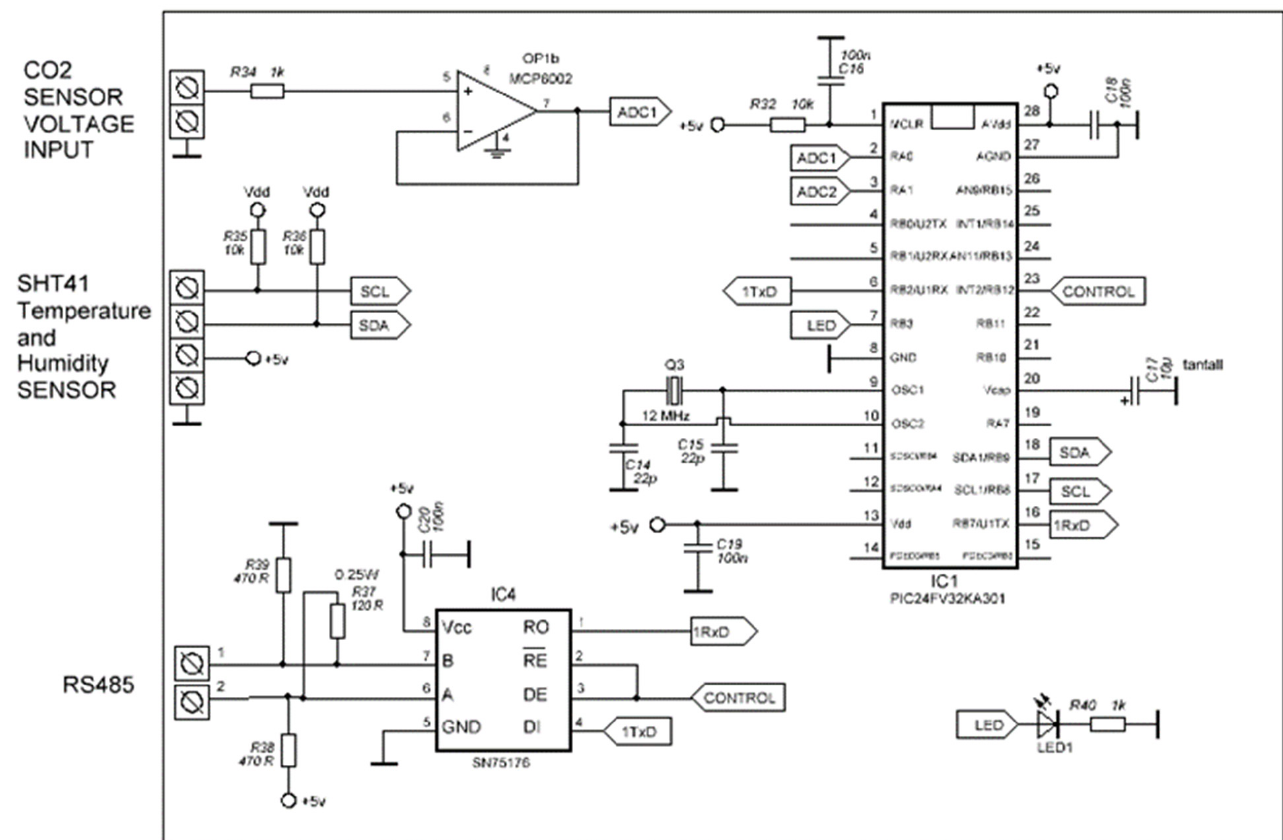
Figure 4. Sensor communication circuit.